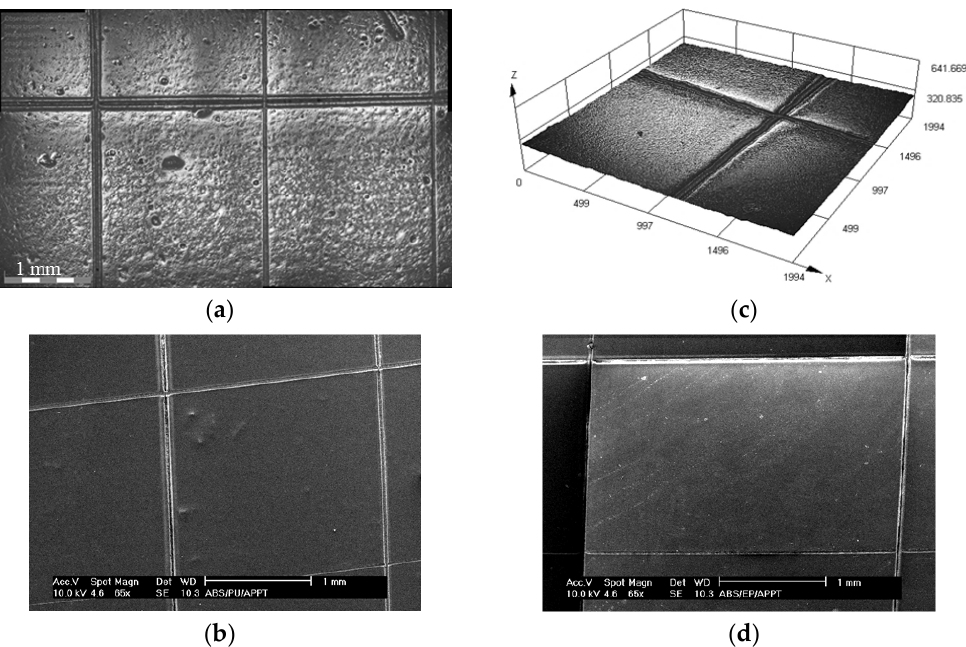
Figure 6. OM micrographs after the cross-cut test on ABS: ( a ) ABS + PU, without APPT treatment and PU paint; ( b ) APS + APPT/PU, without APPT treatment and EP paint. Scanning electronic microscopy (SEM) micrographs after the cross-cut test on ABS: ( c ) ABS + EP, with APPT treatment and PU paint and ( d ) APS + APPT/EP, with APPT treatment and EP paint.